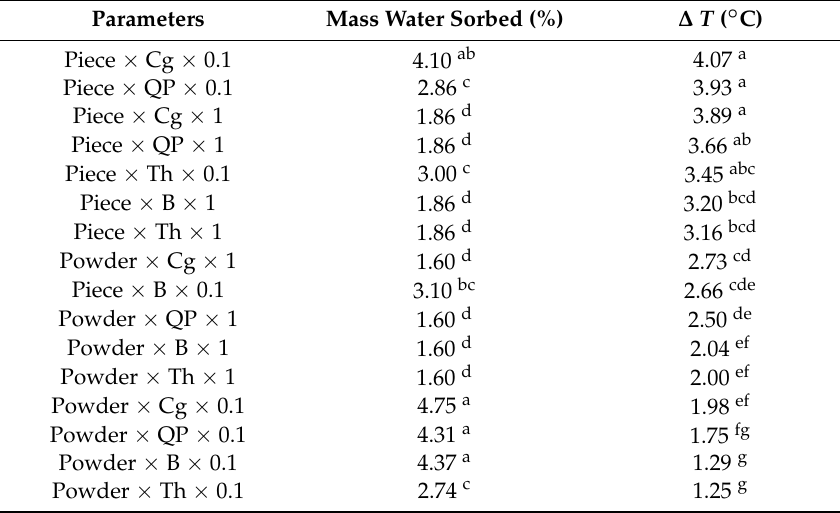
Table 8. Classification by Tukey’s test in decreasing order for T . For each group, the means with the same letter were not significantly different at 5% ( α =